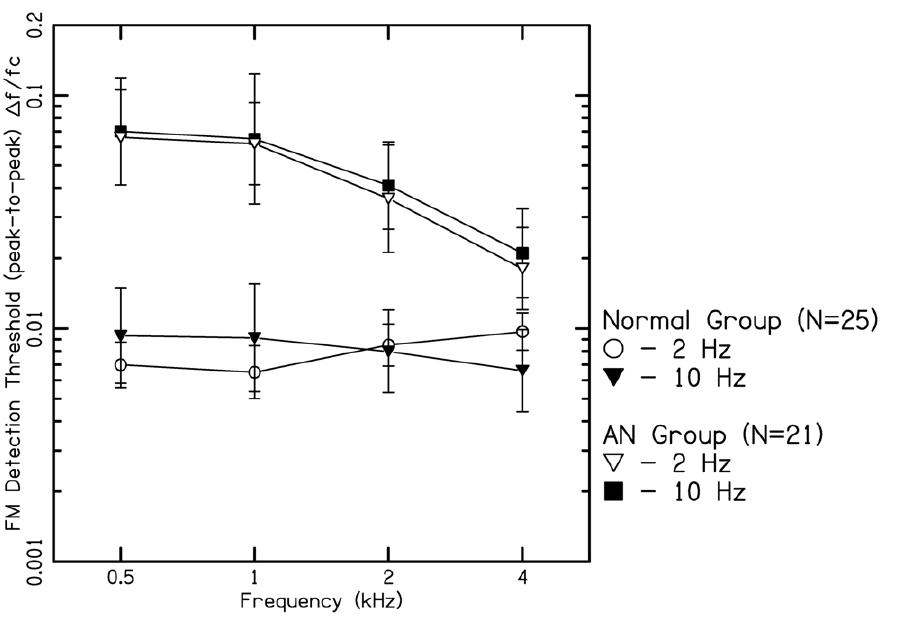
Figure 2. Frequency modulation detection threshold (FMDL) for 2 Hz and 10 Hz modulation frequencies as function of carrier frequencies (0.5, 1, 2, and 4 kHz) expressed as peak-to-peak deviation divided by center frequency in listeners with AN and normal